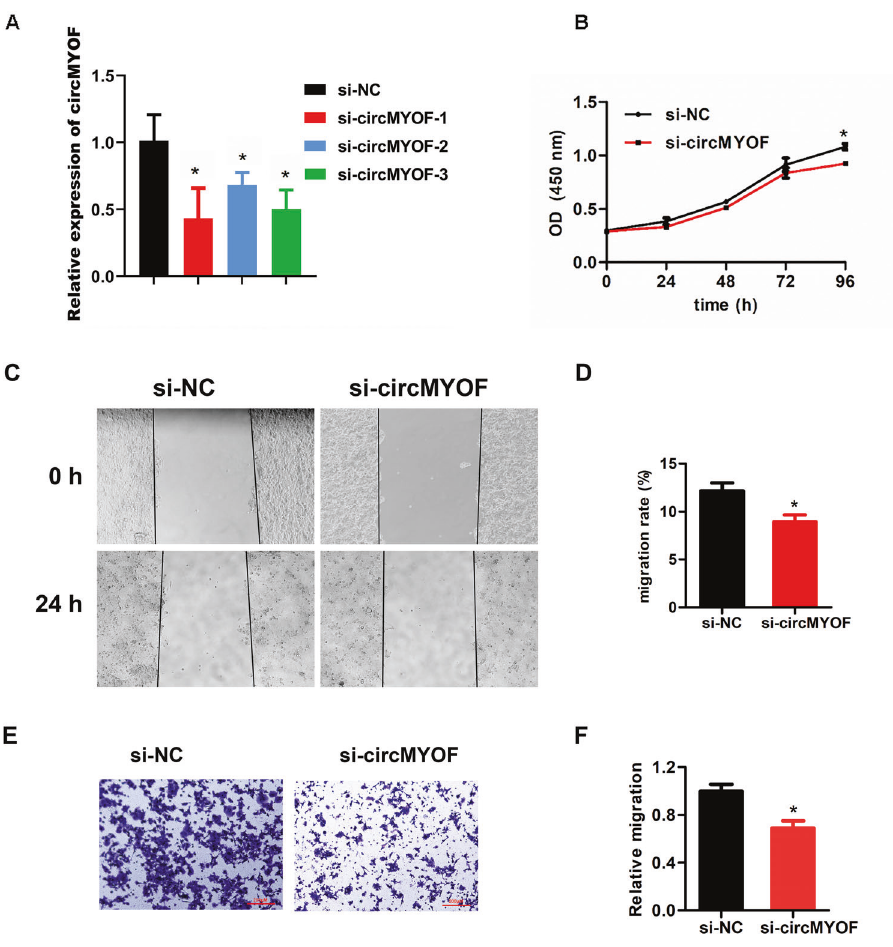
Fig. 3 Downregulation of circMYOF prohibits cell proliferation and progression in PDA in vitro. A Effective suppression of circMYOF expression was performed using siRNAs in HPAF-II cells. B CCK-8 assay results showed that repression of circMYOF expression prohibited cell growth. C , D Wound healing experiments showed that downregulation of circMYOF expression depressed metastatic potential in PDA. E , F Transwell assay showed that attenuation of circMYOF expression inhibited migration. Scale bars: 200 µm. Data are presented as the mean ± SD of three independent experiments. * p < 0.05, *** p <